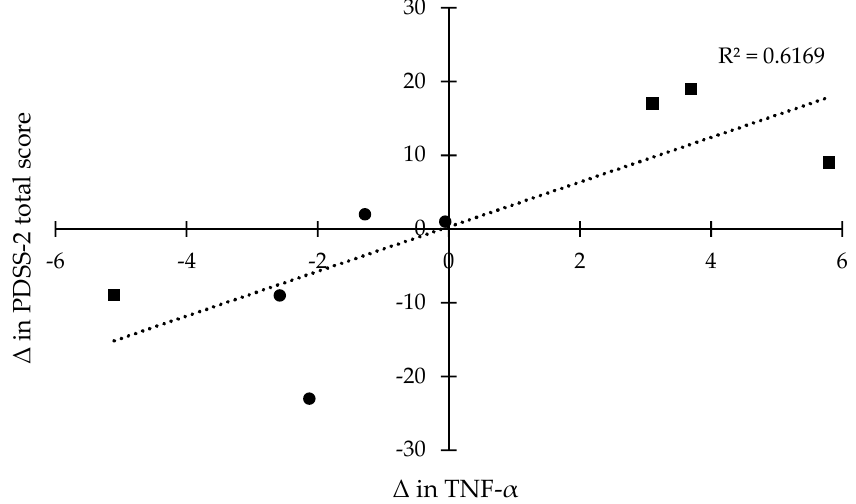
Figure 1. Correlation coefficients (r) between mean changes ( Δ ; Δ = post ‐ score – baseline ‐ score) in the levels of TNF ‐α and mean changes ( Δ ) in PDSS ‐ 2 scores in the experimental ( ● ) and control groups ( ■ ).